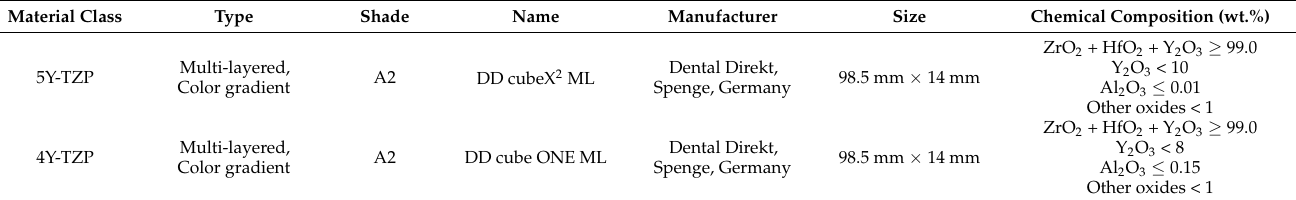
Table 1. List of materials.